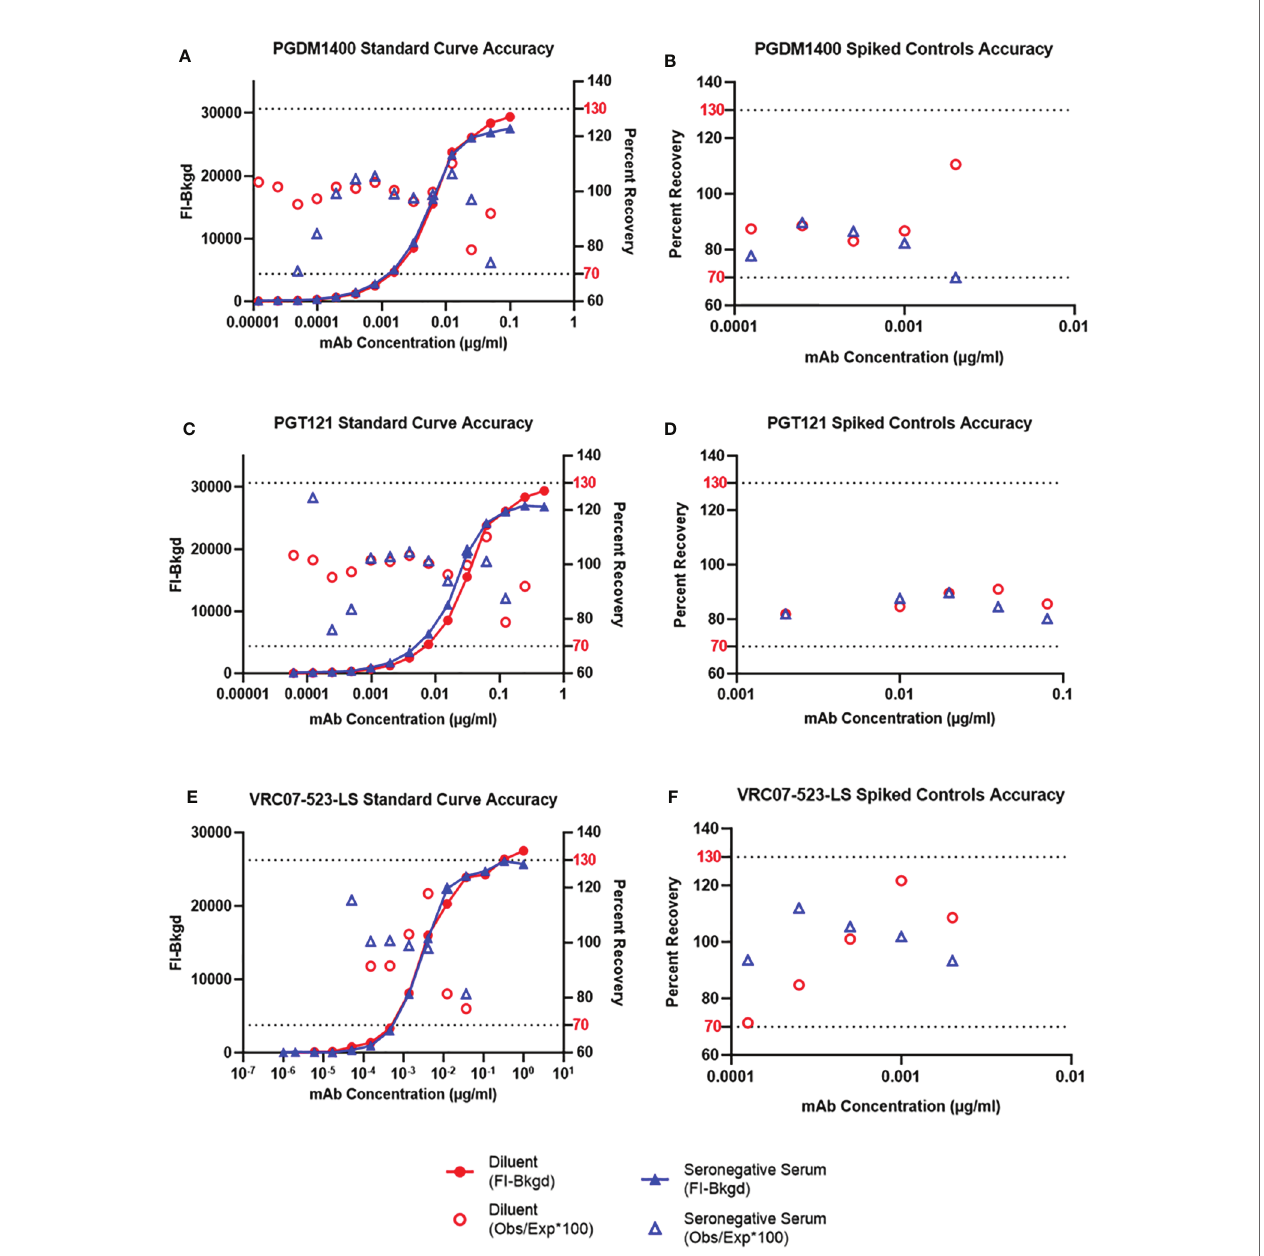
FIGURE 4 | Accuracy of Standard Curves and Spiked Sample Recovery. PGDM1400 IgG (A) , PGT121 IgG (C) and VRC07-523-LS IgG (E) mAbs were titrated in diluent (red), in pooled 1:100 diluted HIV-1 seronegative human serum. PGDM1400 IgG (B) , PGT121 IgG (D) and VRC07-523-LS IgG (F) mAbs were spiked in pooled 1:100 diluted seronegative serum at 5 different concentrations. Observed concentration for each point in the curve was calculated and used to determine accuracy of recovery of each mAb. The dotted lines denote the upper (130% of the expected concentration) and lower (70% of the expected concentration) limits of acceptable percent